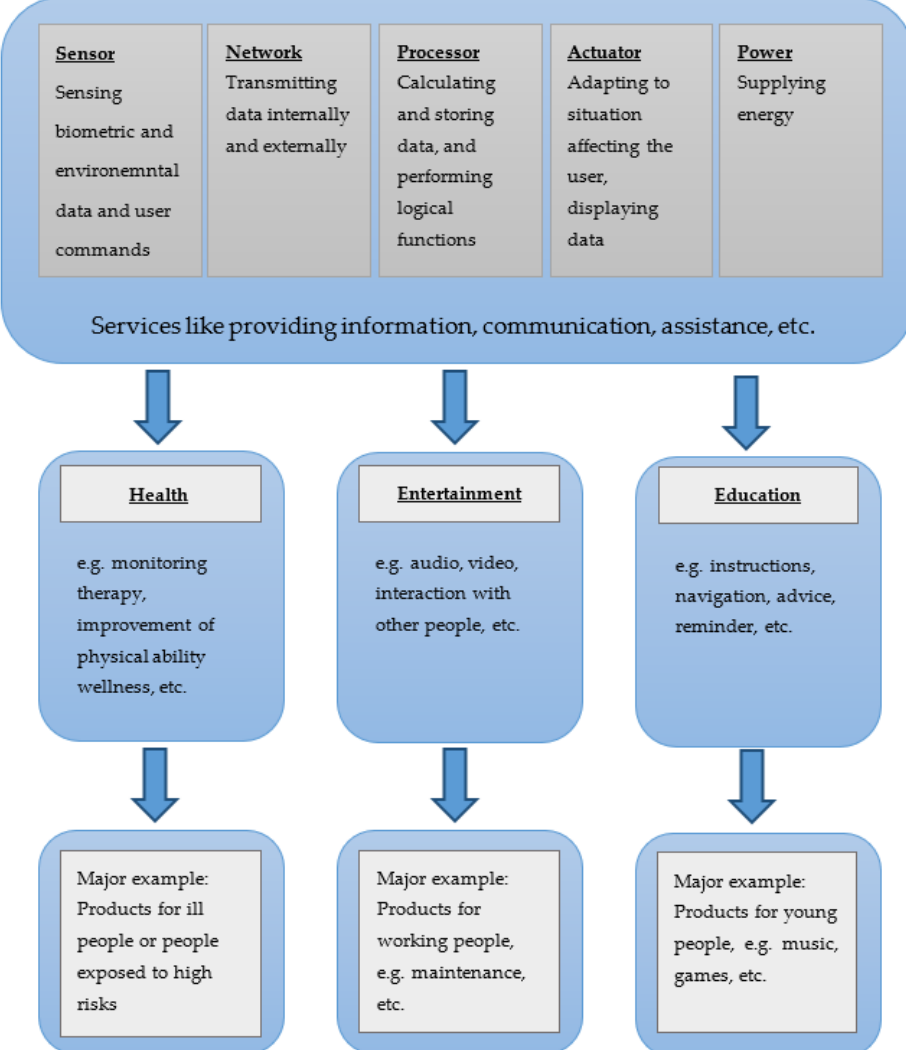
Figure 4. Systemization of wearable electronic systems.